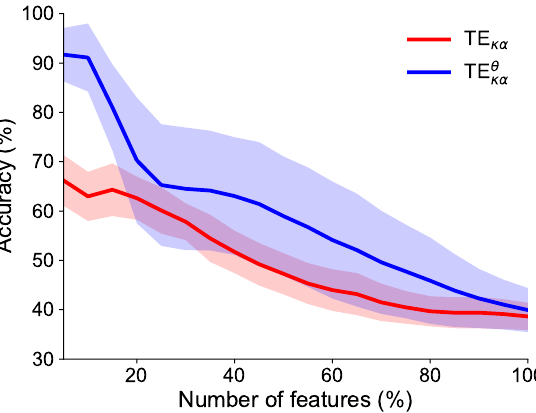
Figure 10. Average classification accuracies, and their standard deviations, for all subjects in the WM database as a function of the number features selected to train the